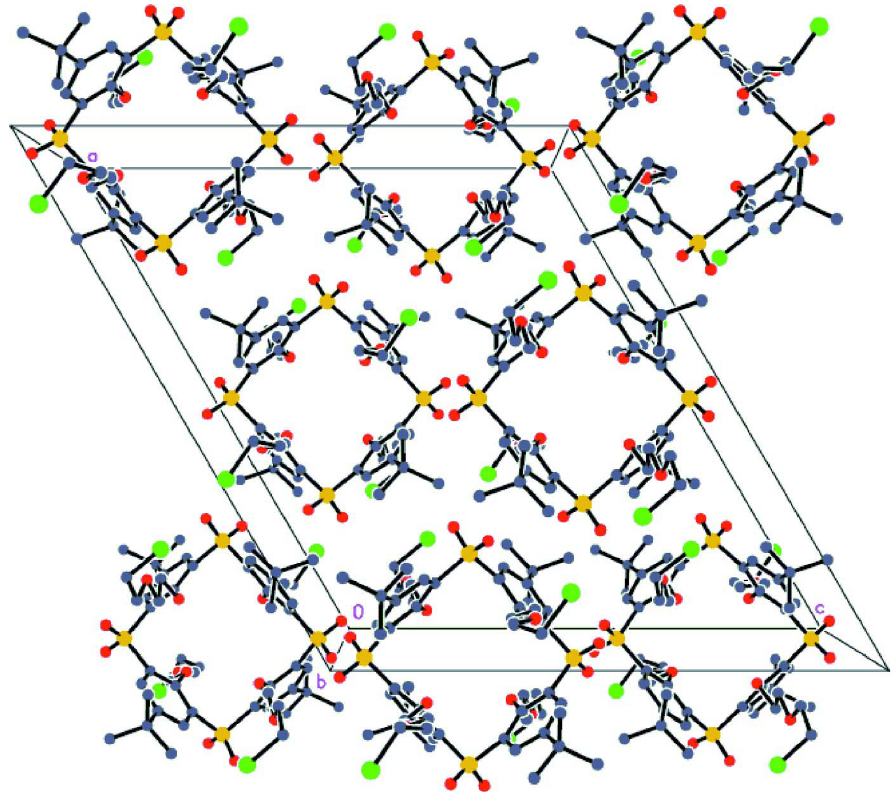
Figure 2 The crystal packing of the title compound viewed along the b axis. Hydrogen atoms and the minor disordered units are omitted for